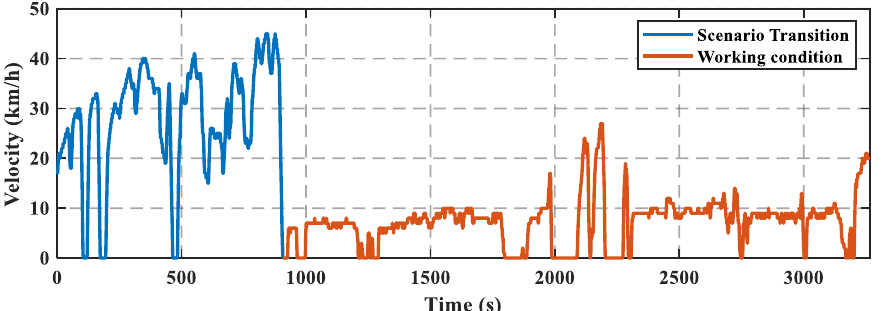
Figure 3. Typical driving cycles of the sanitation vehicle. Although the scenario transition condition part was not of concern, the energy con- sumption analysis covered the whole driving cycle to reasonably evaluate the principal power components. Generally speaking, the energy stored in the battery was consumed by the driving motor (DM), the working motor (WM), an air compressor (AC) used for braking, a steering motor vehicle (SM), and a DCDC (DC-to-DC converter) connected with low-voltage accessories. Figure 4 illustrates the power curves of these components sampled from the cleaning routine. Specifically, under the driving mode, the working motor was kept off. The driving motor consumed power varying from − 120 kW to 120 kW, in which being positive means that battery energy was consumed by the driving motor and being negative means that the electricity was regenerated by the driving motor from braking and restored to the battery. While under the working mode, the working motor steadily consumed power at about 50 kW, and extremely low operating power was consumed by the driving motor due to the low velocity. In Figure 5, the operating states consisting of the rotating speed and the torque of the working motor are displayed. In Figure 4, even though the peak power overpassed 20 kW, it is indicated that the steering motor and air compressor merely occasionally consumed that power for a relatively short time. The energy consumption proportions of these devices are shown in Figure 6. Taking the whole driving cycle into consideration, the sum of energy consumed by the two motors took a proportion up to 89%. Consequently, aiming at a better energy economy of the sanitation vehicle, only these two motors’ operating states were analyzed and targeted in the optimization method to acquire optimal control